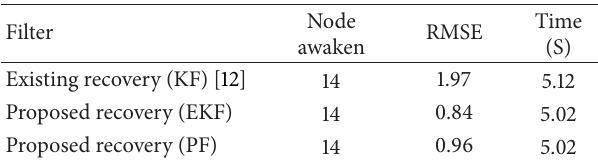
Table 9: Performance comparison: coverage hole in